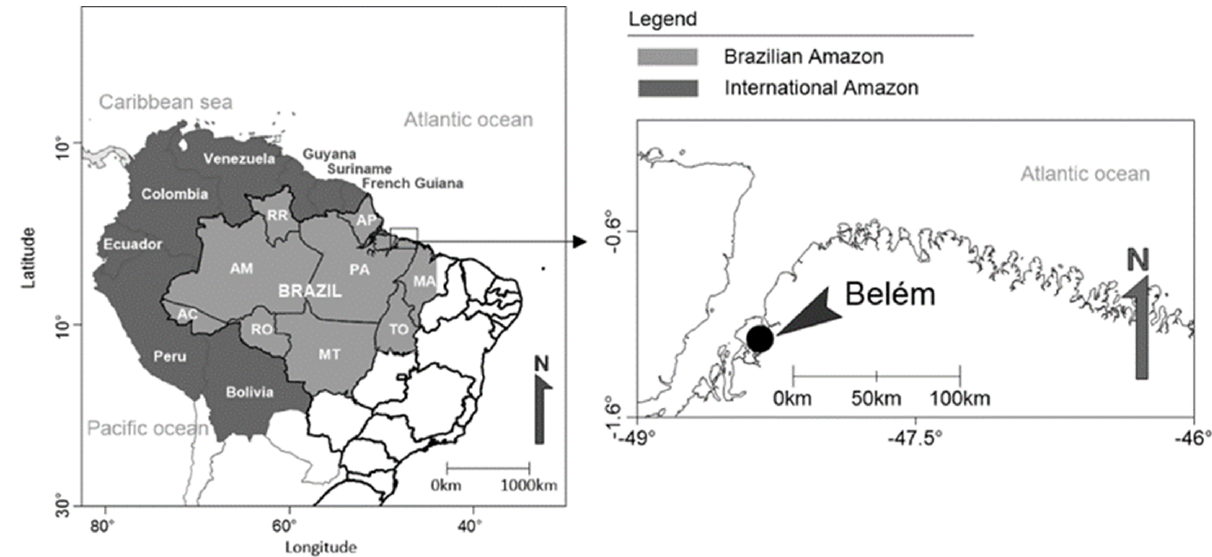
Figure 1. Geographic location of the city of Belém, in the Brazilian state of Pará (PA), Amazon region. Belém is the second largest city in the Brazilian Amazon.